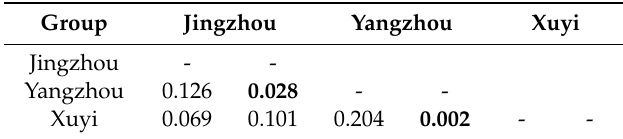
On the left is R value indicating the correlation. On the right is p value indicating significant differences. Bold values represent significant differences ( p < 0.05) between pairwise stages. Table 3. ANOSIM of crayfish gut microbiota based on Bray–Curtis distance calculated with partial 16S rRNA sequences.